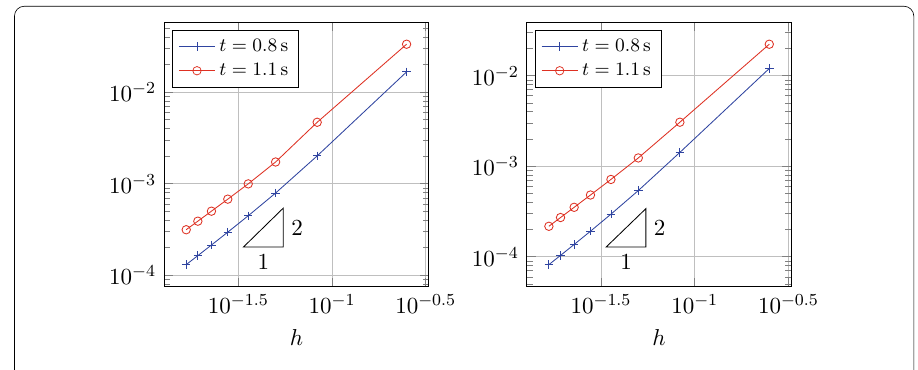
Fig. 10 Convergence of scheme (QIP) w.r.t. the space step h , for final time t = 0 . 8s, t = 1 . 1s for a